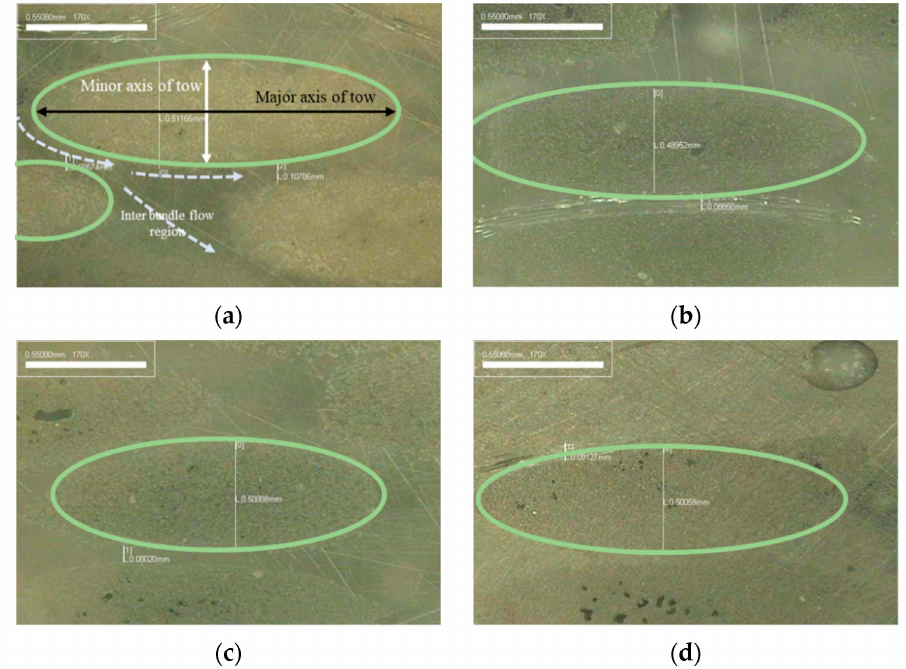
Figure 7. Microscopic images of the tow in the fiber bundle from the inlet to the outlet position at 50 mm 3 /s of flow rate. ( a ): 60 mm, ( b ): 180 mm, ( c ): 300 mm, ( d ): 420